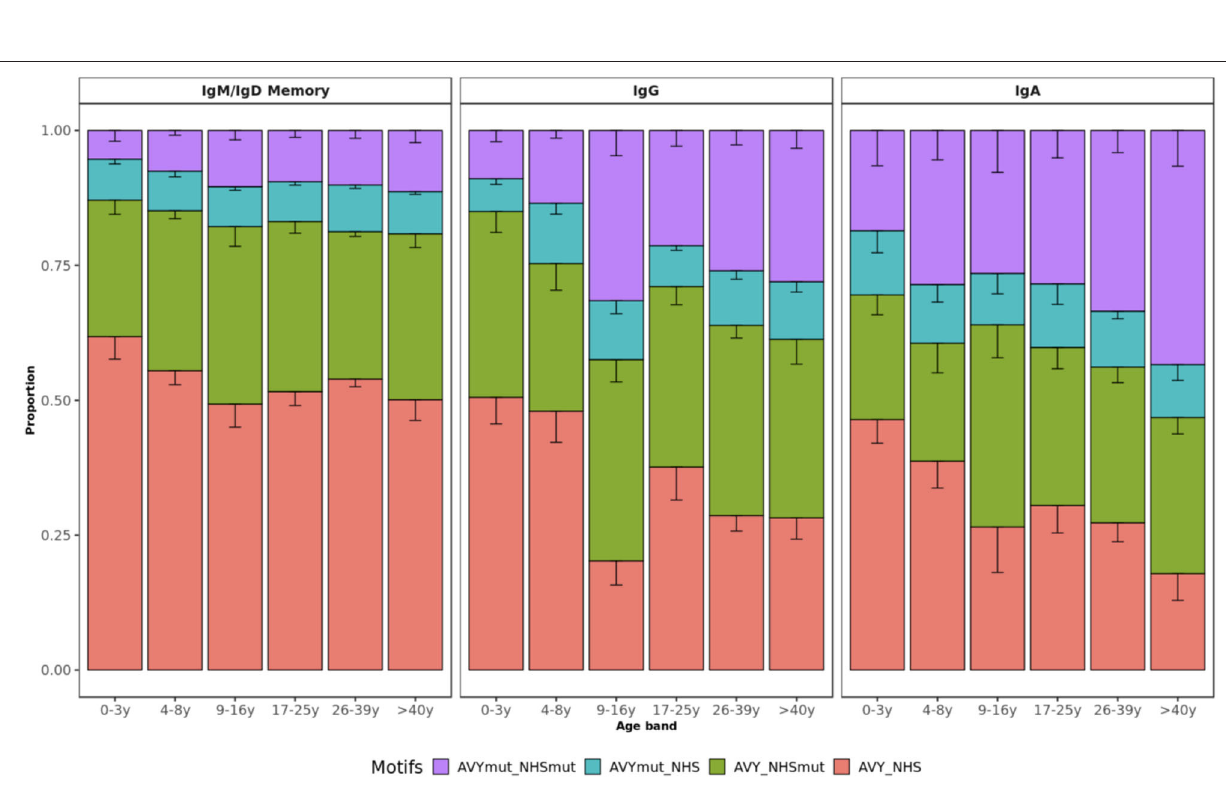
Frontiers in Immunology | www.frontiersin.org